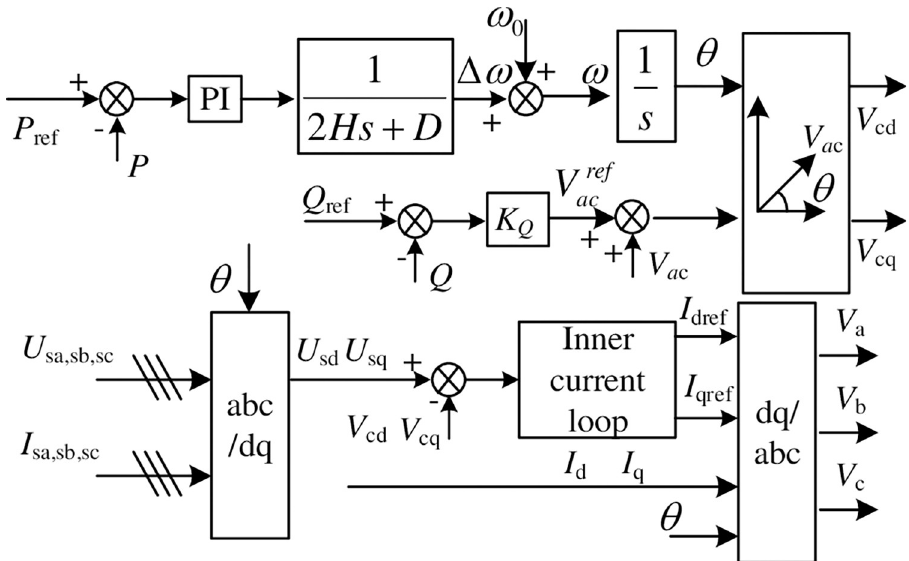
Fig 7. Constant active power control structure based on traditional VSG